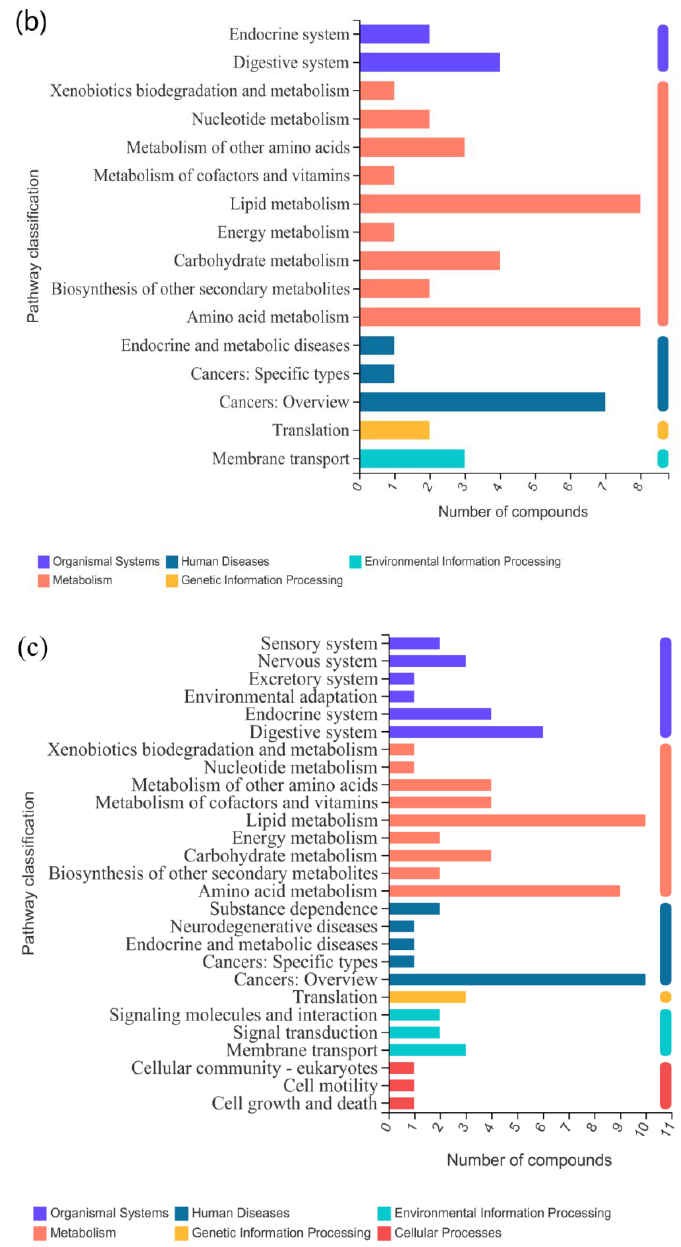
Figure 6. KEGG pathway classification of differently expressed metabolites. ( a ) KEGG pathway classification between CAP-30 and control group; ( b ) CAP-70 and control group; and ( c ) CAP-100 and control group. Table 10. List of discriminating KEGG metabolites in CAP-30, CAP-70, CAP-100 and control groups.